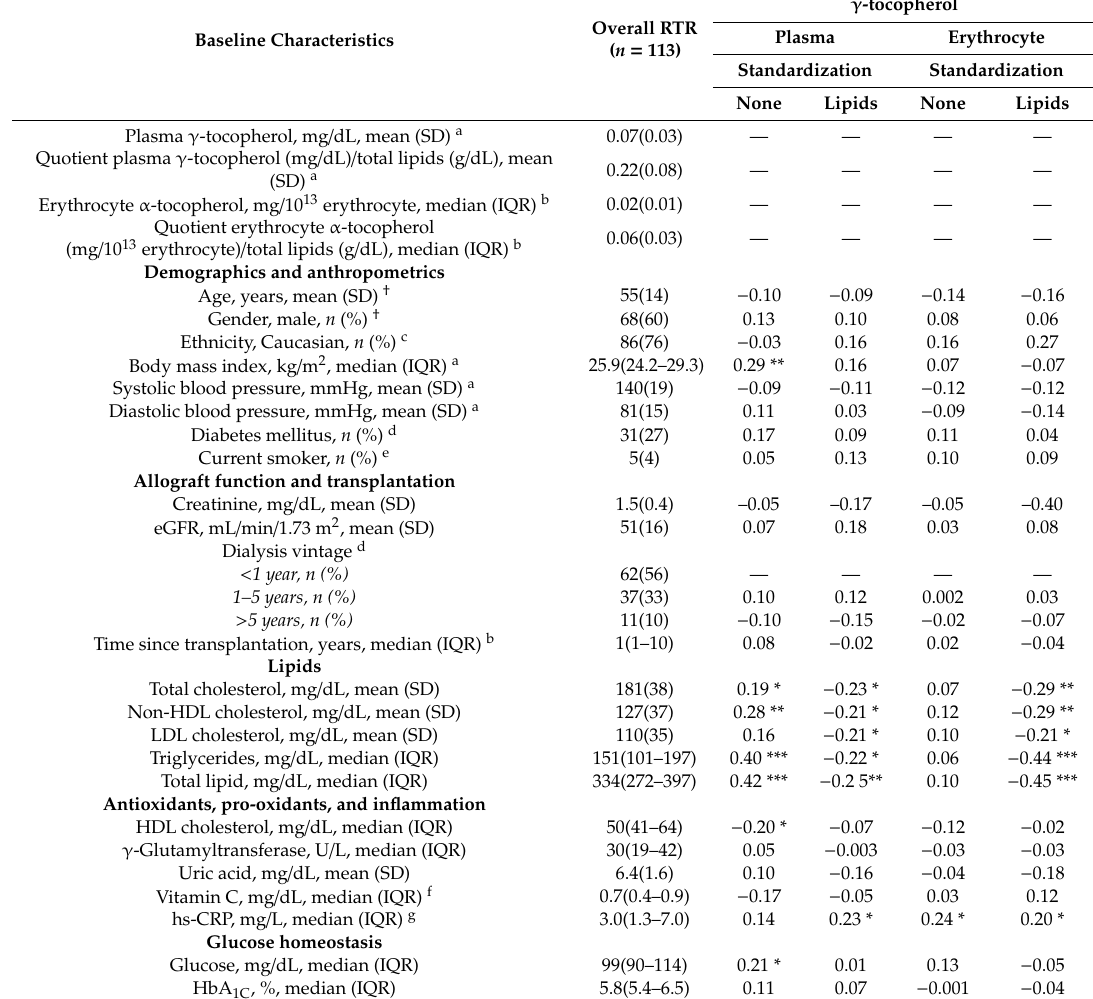
Table 4. Baseline characteristics of renal transplant recipients, and their associations with non-standardized and total lipids-standardized plasma and erythrocyte γ -tocopherol concentrations. γ -tocopherol Overall RTR Plasma Erythrocyte Baseline Characteristics ( n = 113) Standardization Standardization None Lipids None Lipids Plasma γ -tocopherol, mg / dL, mean (SD) a 0.07(0.03) — — — — Quotient plasma γ -tocopherol (mg / dL) / total lipids (g / dL), mean — — — — (SD) a Erythrocyte α -tocopherol, mg / 10 13 erythrocyte, median (IQR) b 0.02(0.01) — — — — Quotient erythrocyte α -tocopherol — — — — (mg / 10 13 erythrocyte) / total lipids (g / dL), median (IQR) b Demographics and anthropometrics Age, years, mean (SD) †